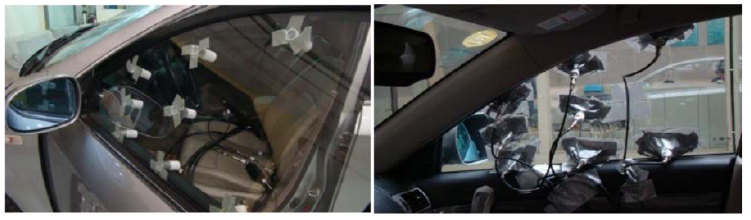
Figure 7. Layout to measure noise intensity.